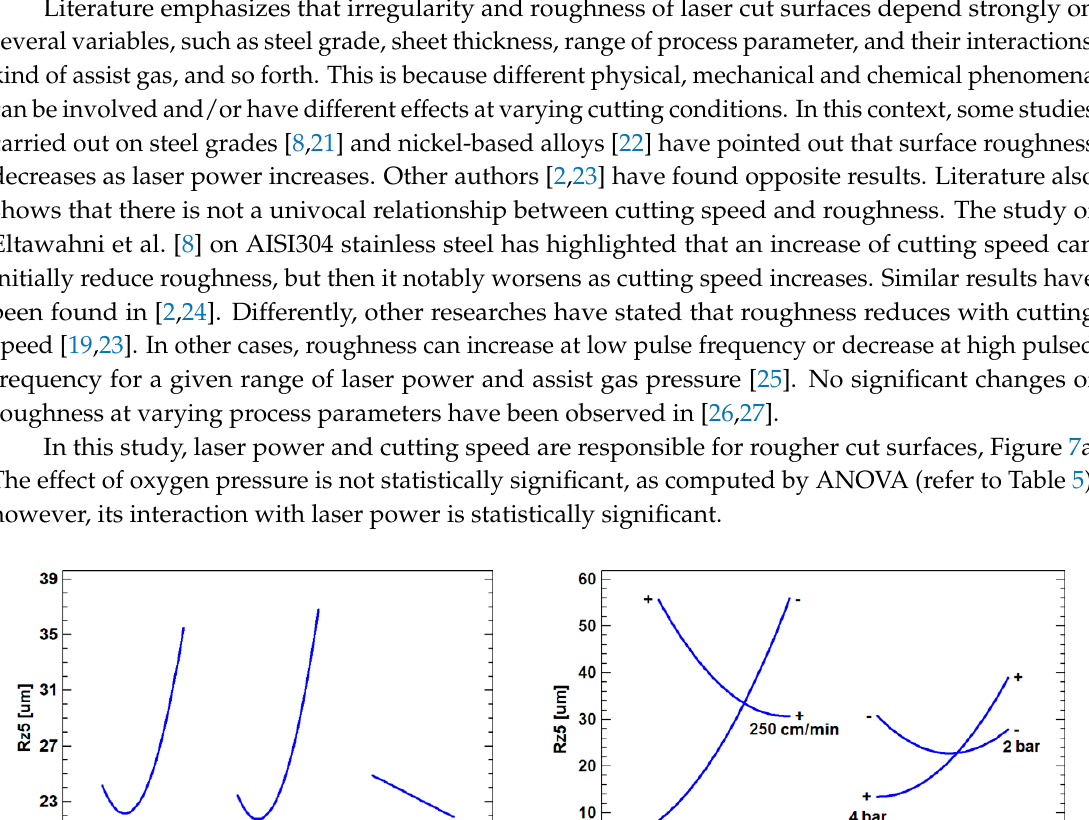
Figure 6. Response surface plot for the effects of the cutting parameters on perpendicularity tolerance (PT). Oxygen pressure 3 bar.